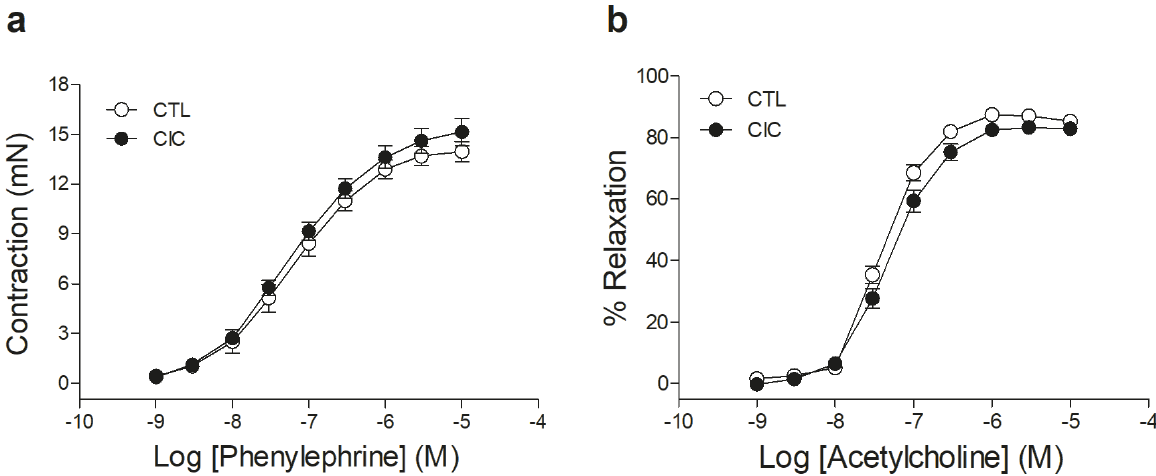
Figure 4. Vascular reactivity of aorta. Concentration-response curves for phenylephrine (a) and acetylcholine (b) in aortic rings isolated from CTL (n = 6) and CIC (n = 9) rats after the treatment period. Data are expressed as mean ±